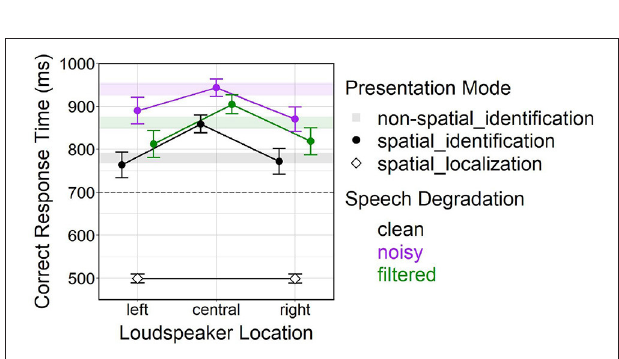
FIGURE 5 | Effects of speech degradation and loudspeaker location on correct response time in the spatial_id mode. Color-shaded bars represent 95% confidence ranges for the non-spatial_id mode under different speech degradation levels (i.e., black bar = non-spatial_id/clean, purple bar = non-spatial_id/noisy, green bar = non-spatial_id/filtered), as depicted in Figure 4 . Diamond-shaped points represent the spatial_loc mode (talker-localization task). Error bars represent 95% confidence intervals. The dashed horizontal line at 700 ms marks the lower y-axis limit in Figure 4 , for better comparability. Another version of this figure originally appeared in Uhrig (2022), copyright 2021, with permission from